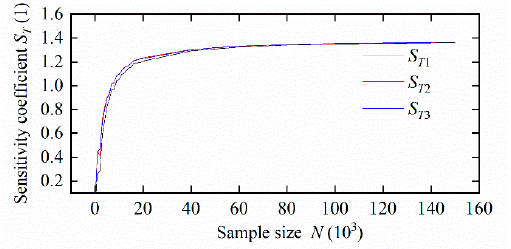
Figure 13. Global sensitivity coefficient with changing sample size.